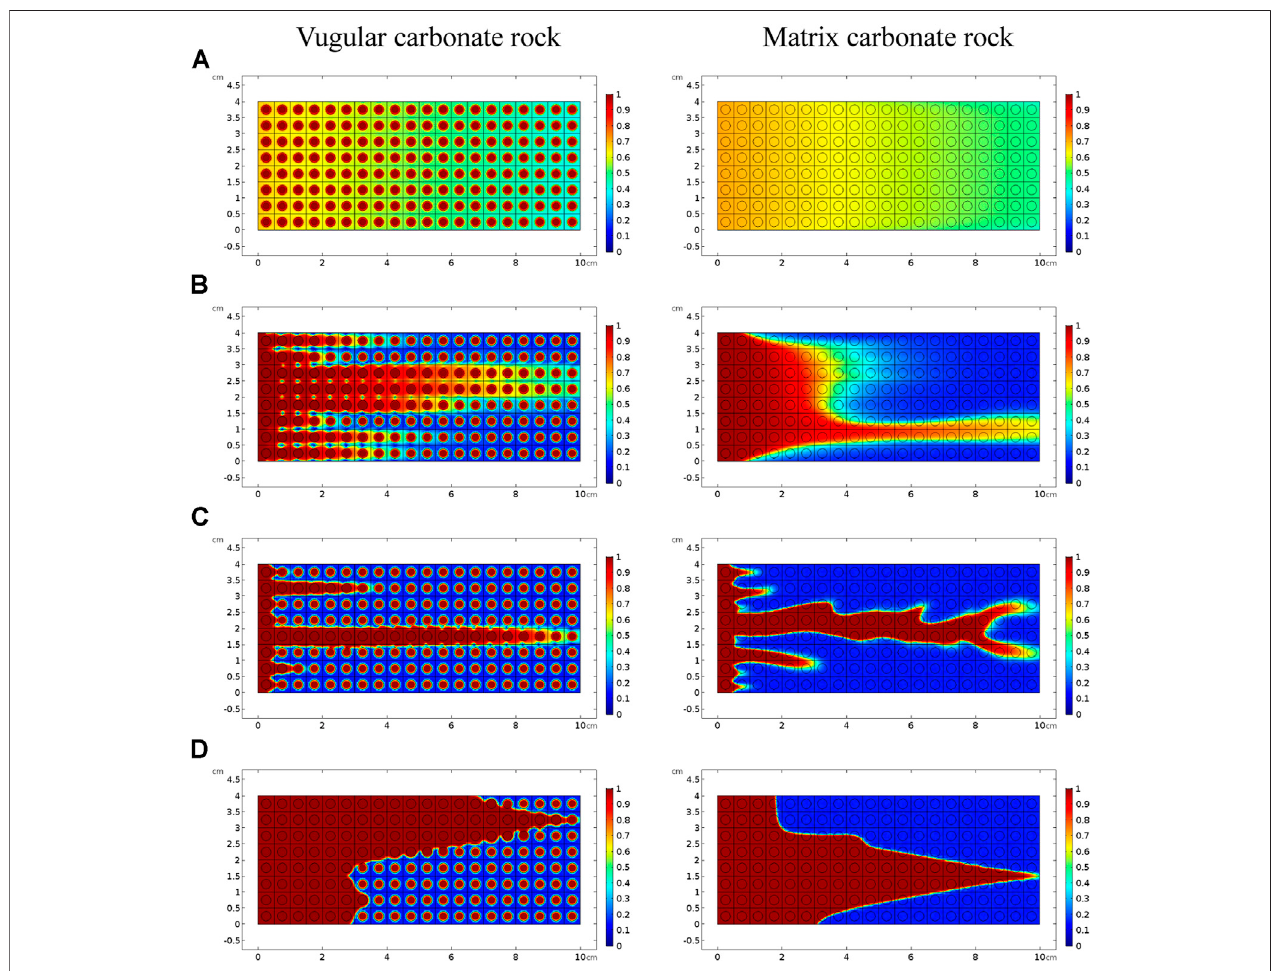
FIGURE 4 | Comparison of dissolution patterns with different acid injection velocities: (A) 0.5 cm/s, (B) 0.05 cm/s, (C) 0.005 cm/s, and (D) 0.0005 cm/s.